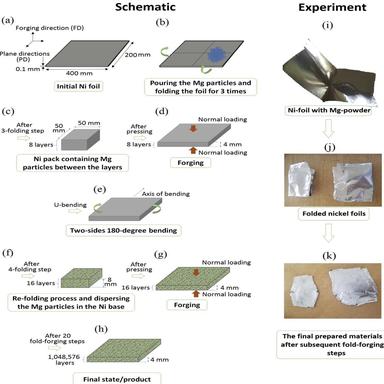
Schematic plots illustrate the different stages for the accomplishment of AFF treatment as combined with the experimental details. Schematic: (a) Primary nickel foil, (b) introducing of magnesium powder, (c) first stacking of foil layers, (d) pressing to bond the stacked layers, (e) U-bending for continuing the fold-forging steps, (f) next folding stage, (g) subsequent forging and (h) final state of layered composite structure with 1,048,576 number of layers. Experiment: (i) The real primary nickel foil wi